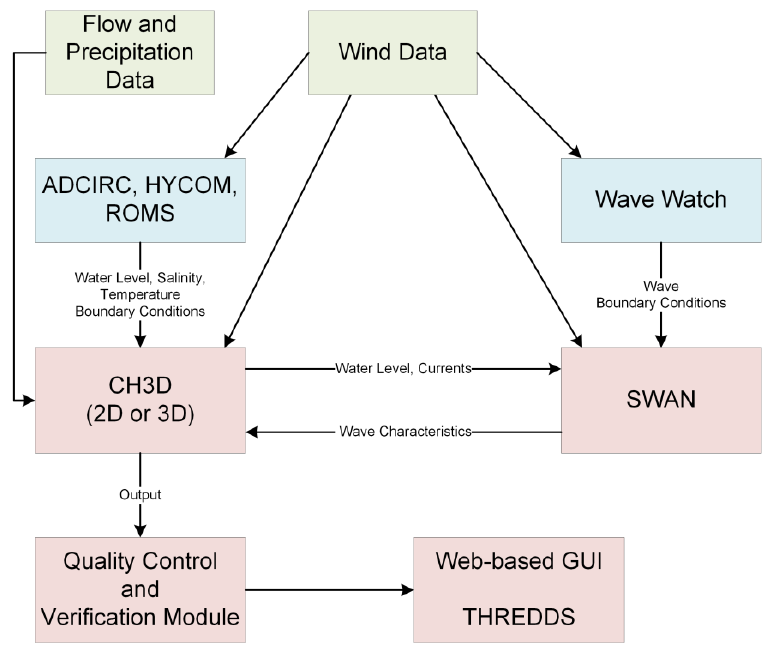
Figure 2. ACMS workflow diagram.